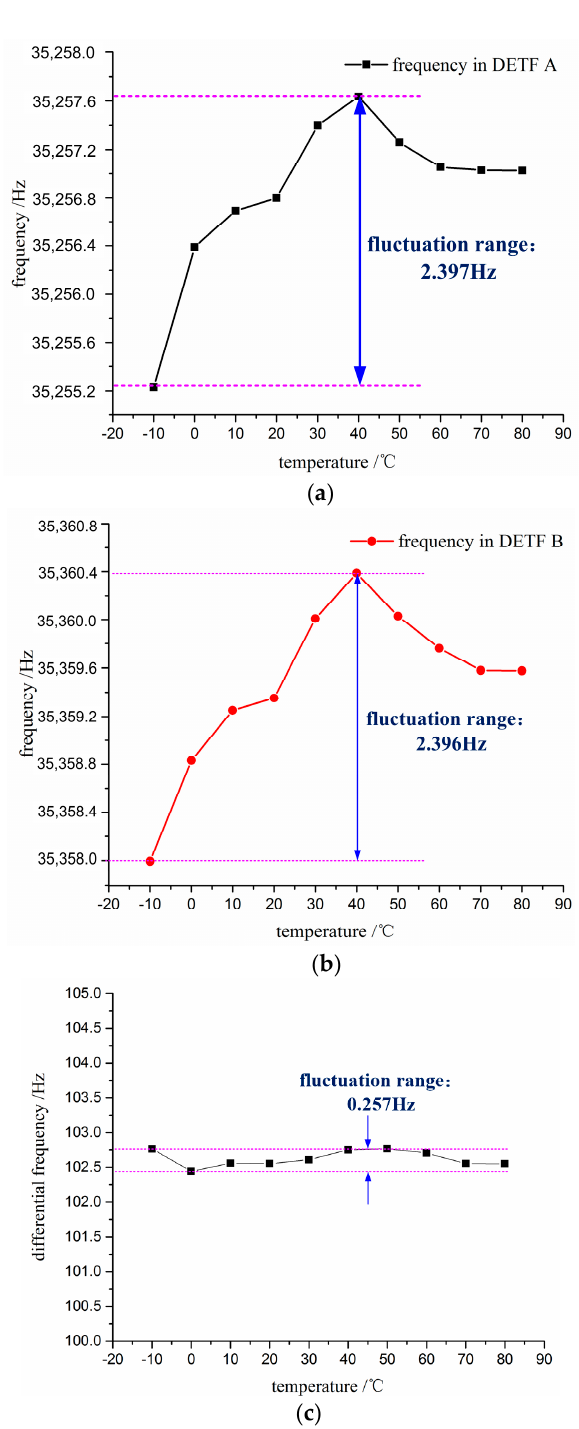
Figure 24. Experimental data of temperature drift: ( a ) temperature drift in DETF A; ( b ) temperature drift in DETF B; and ( c ) temperature drift of the differential frequency.